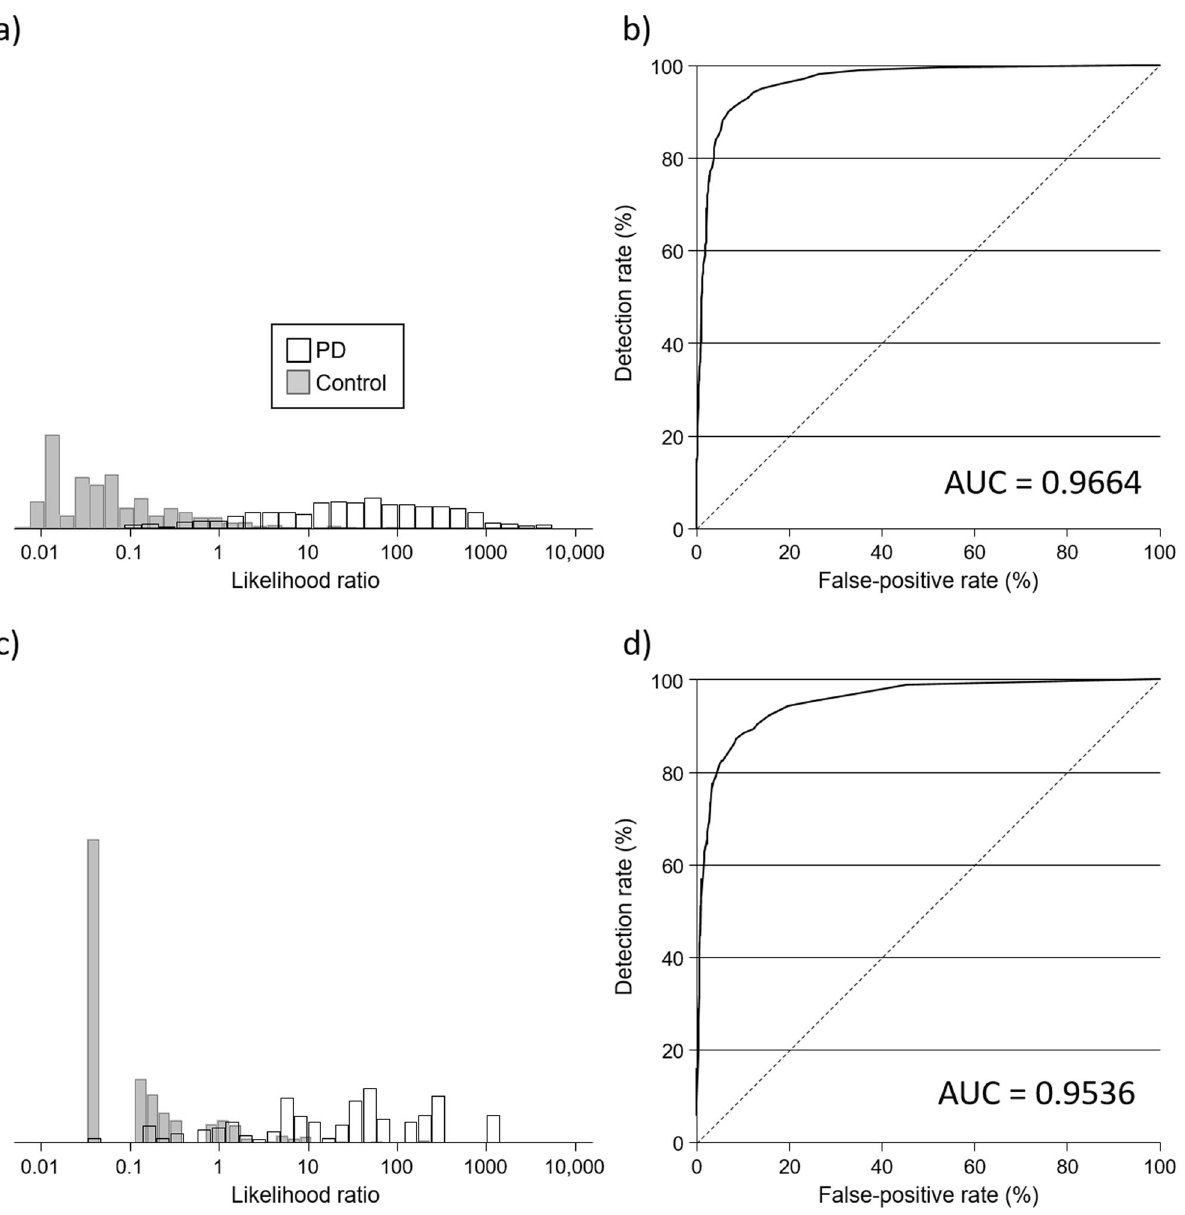
Fig. 1 Classi fi cation of Parkinson ’ s Disease (PD) based on smell. a Distribution of likelihood ratios among PD cases and controls using the 16 odours of the University of Pennsylvania Smell Identi fi cation test (UPSIT) common to both the UK and US versions of the UPSIT identi fi ed as being associated with PD (see Table 1). b Observed detection rate according to false-positive rate (receiver operating characteristic [ROC] curve) for the 16 odours of the UPSIT identi fi ed as being associated with PD. c Distribution of likelihood ratios among PD cases and controls using the 6 odours common to both the UK and US versions of the UPSIT most strongly associated with PD (see Table 1). d ROC curve for the 6 odours of the UPSIT most strongly associated with PD. AUC, area under the receiver operating characteristic